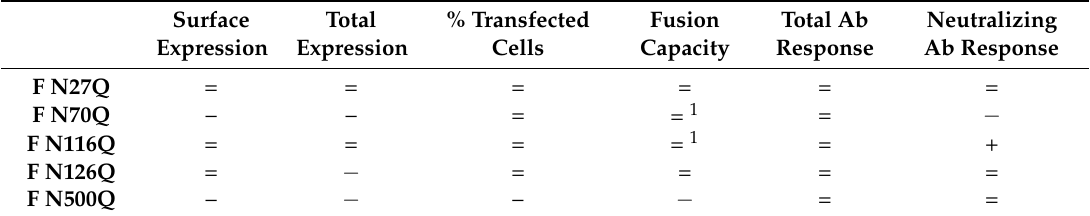
Table 1. Overview of RSV F glycomutants. =, comparable to F WT; +, higher then F WT; − , lower then F WT. Surface Total % Transfected Fusion Total Ab Neutralizing Expression Expression Cells Capacity Response Ab